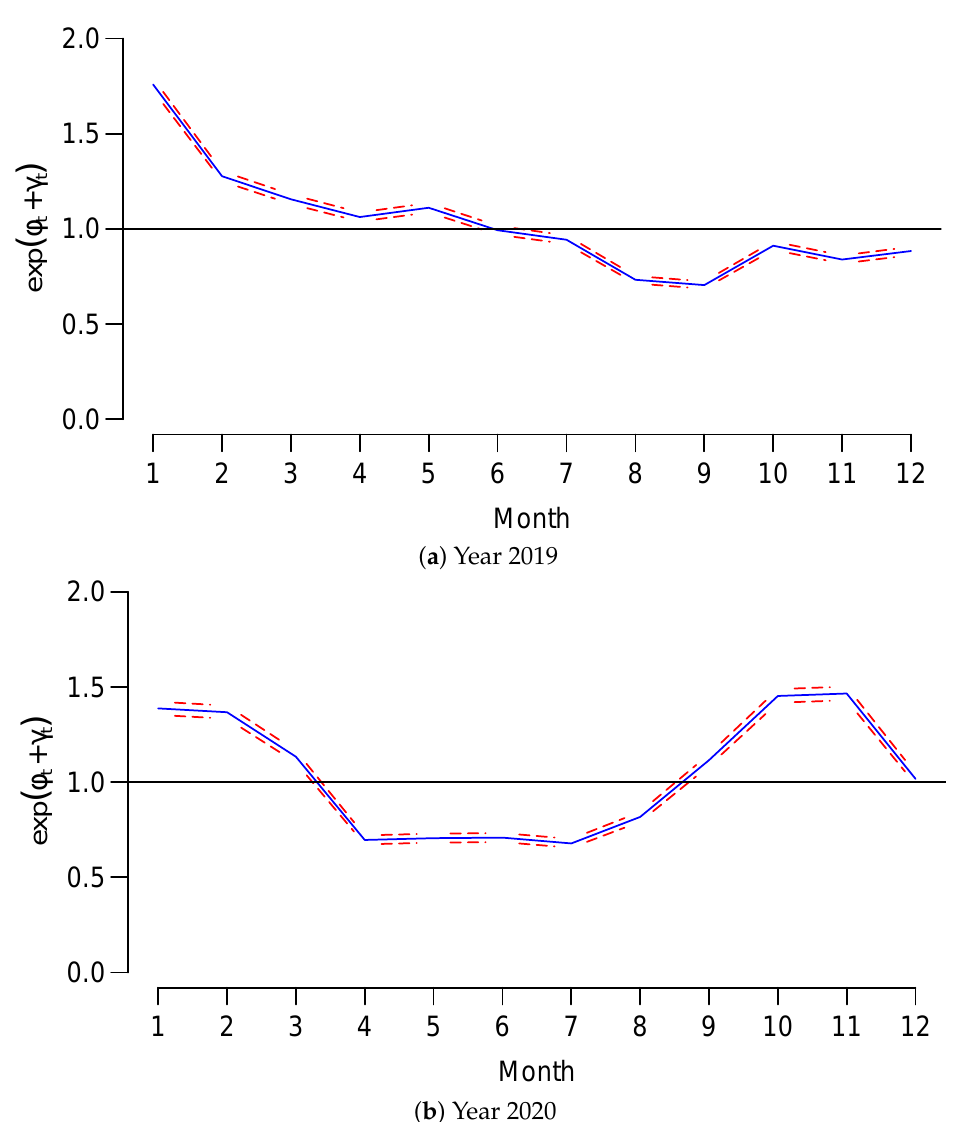
Figure 6. Posterior temporal trend effect for malaria relative risk: exp ( φ t + γ t ) with 95% credible interval, year